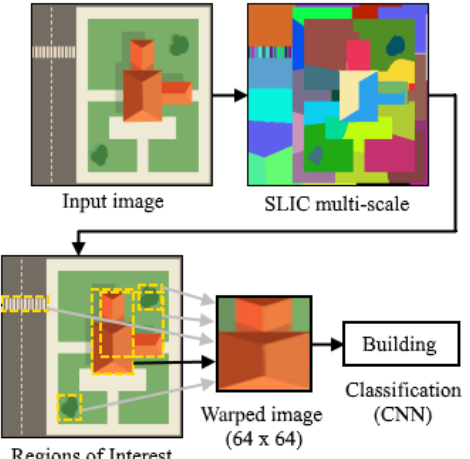
Figure 1 – Proposed approach for object extraction and classification from high resolution aerial